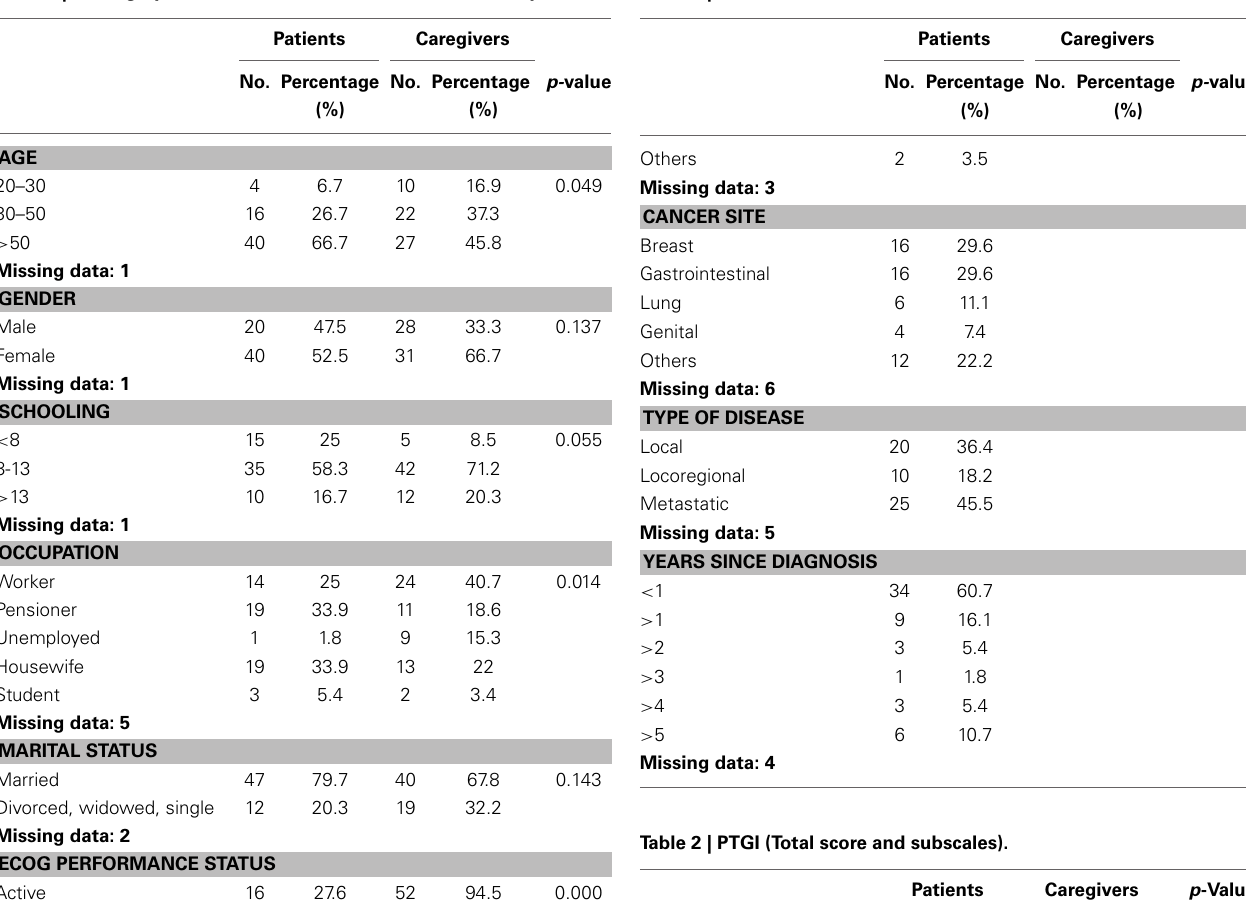
Table 1 | Demographic and clinical characteristics of the